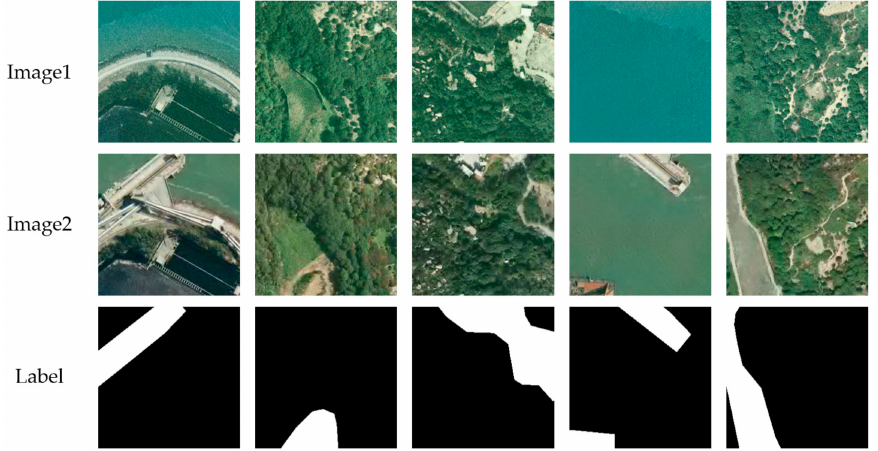
Figure 5. Example of bitemporal input and labels in SYSU-CD.